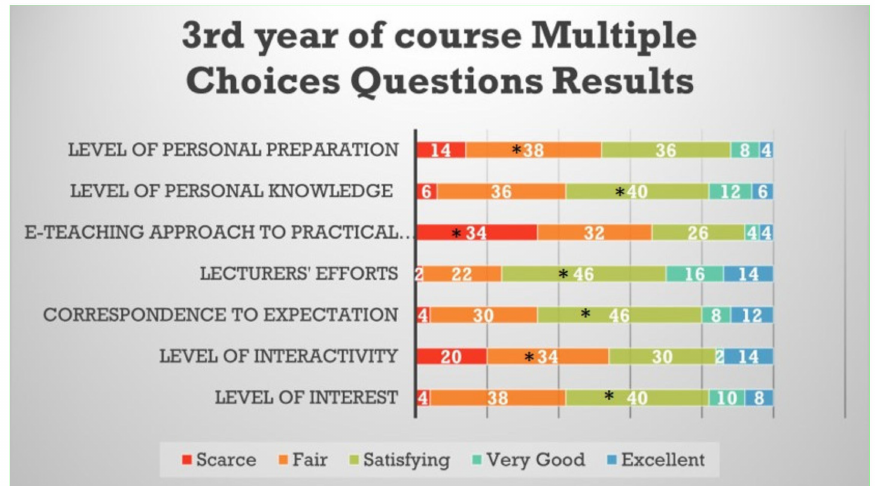
Figure 4. Questionnaire results for the third year student feedback to the e-learning and e-teaching approach. The numbers in the bars indicate the percentages of the answers received ( n = 301). * p < 0.05 (Pearson’s chi-squared